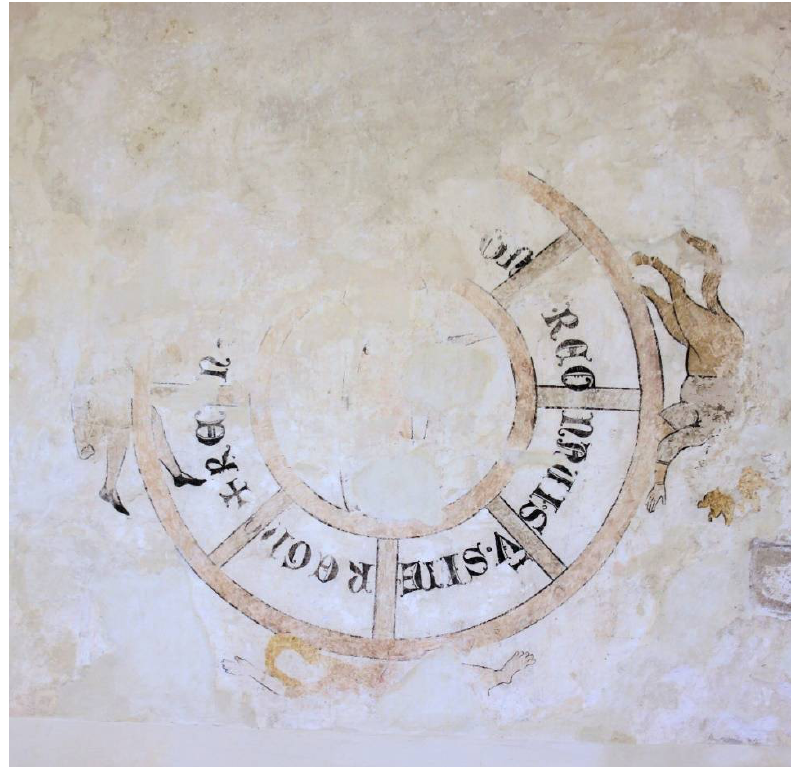
Figure 17. Strakonice, castle, Wheel of Fortune, around 1300. Photo by František Záruba, the author’s own work.